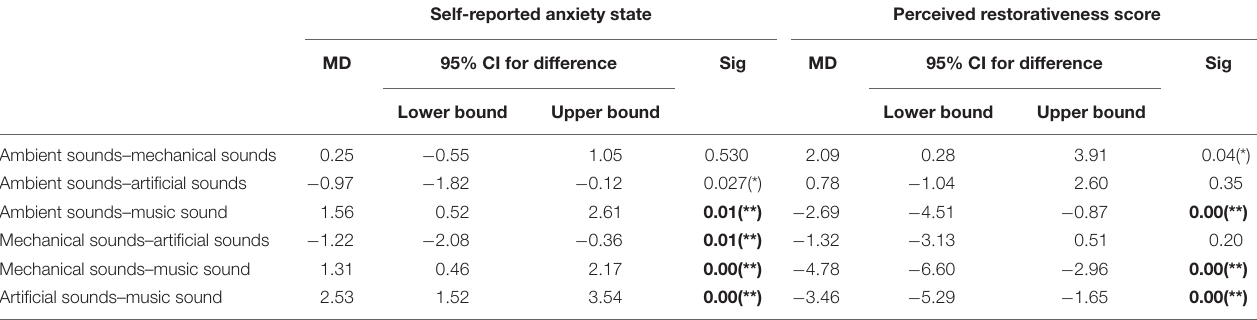
TABLE 2 | Pairwise comparison of psychological stress recovery levels in patients.